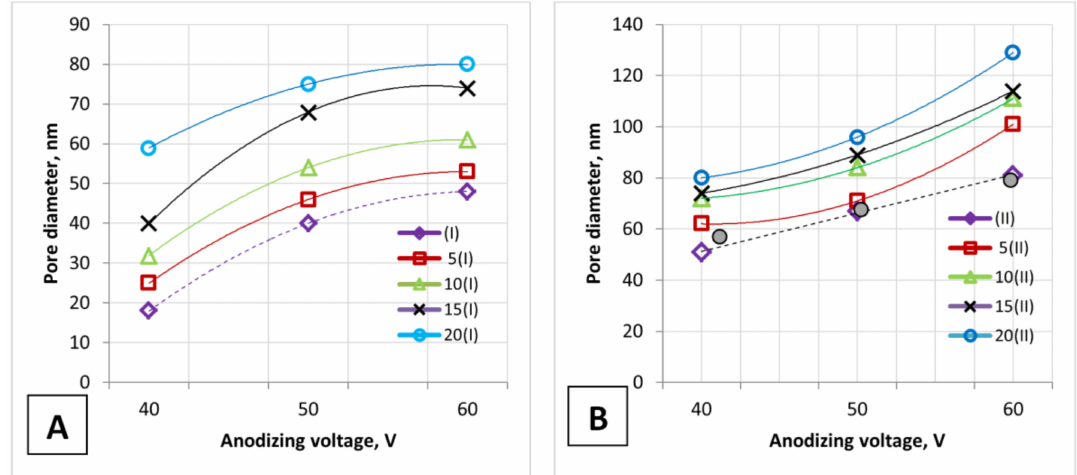
Figure 3. The anodizing voltage influence on the PAA pore diameter: ( A )—one-stage anodizing and ( B )—two-stage anodizing. The calculated values are shown as shaded circles.